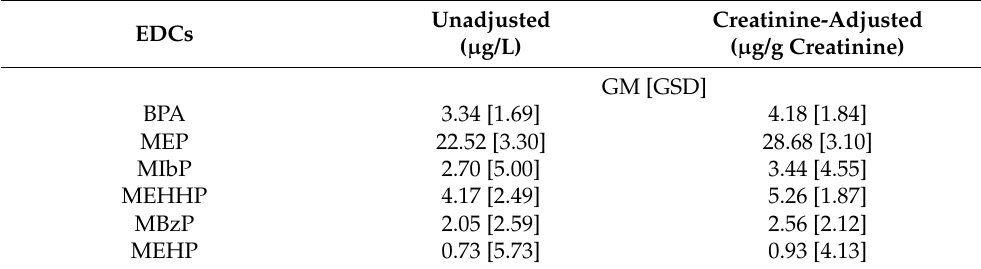
Table 4. Urinary concentrations of phthalates and BPA. Data are presented as geometric mean (GM) and standard geometric deviation